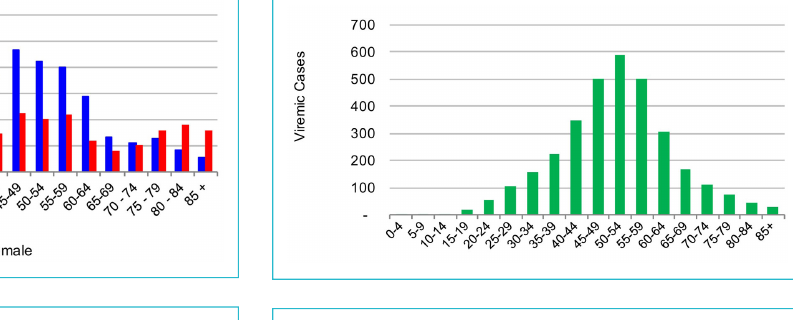
Figure 2: Age and sex distribution of hepatitis C cases in the can- ton of Geneva in 2015.